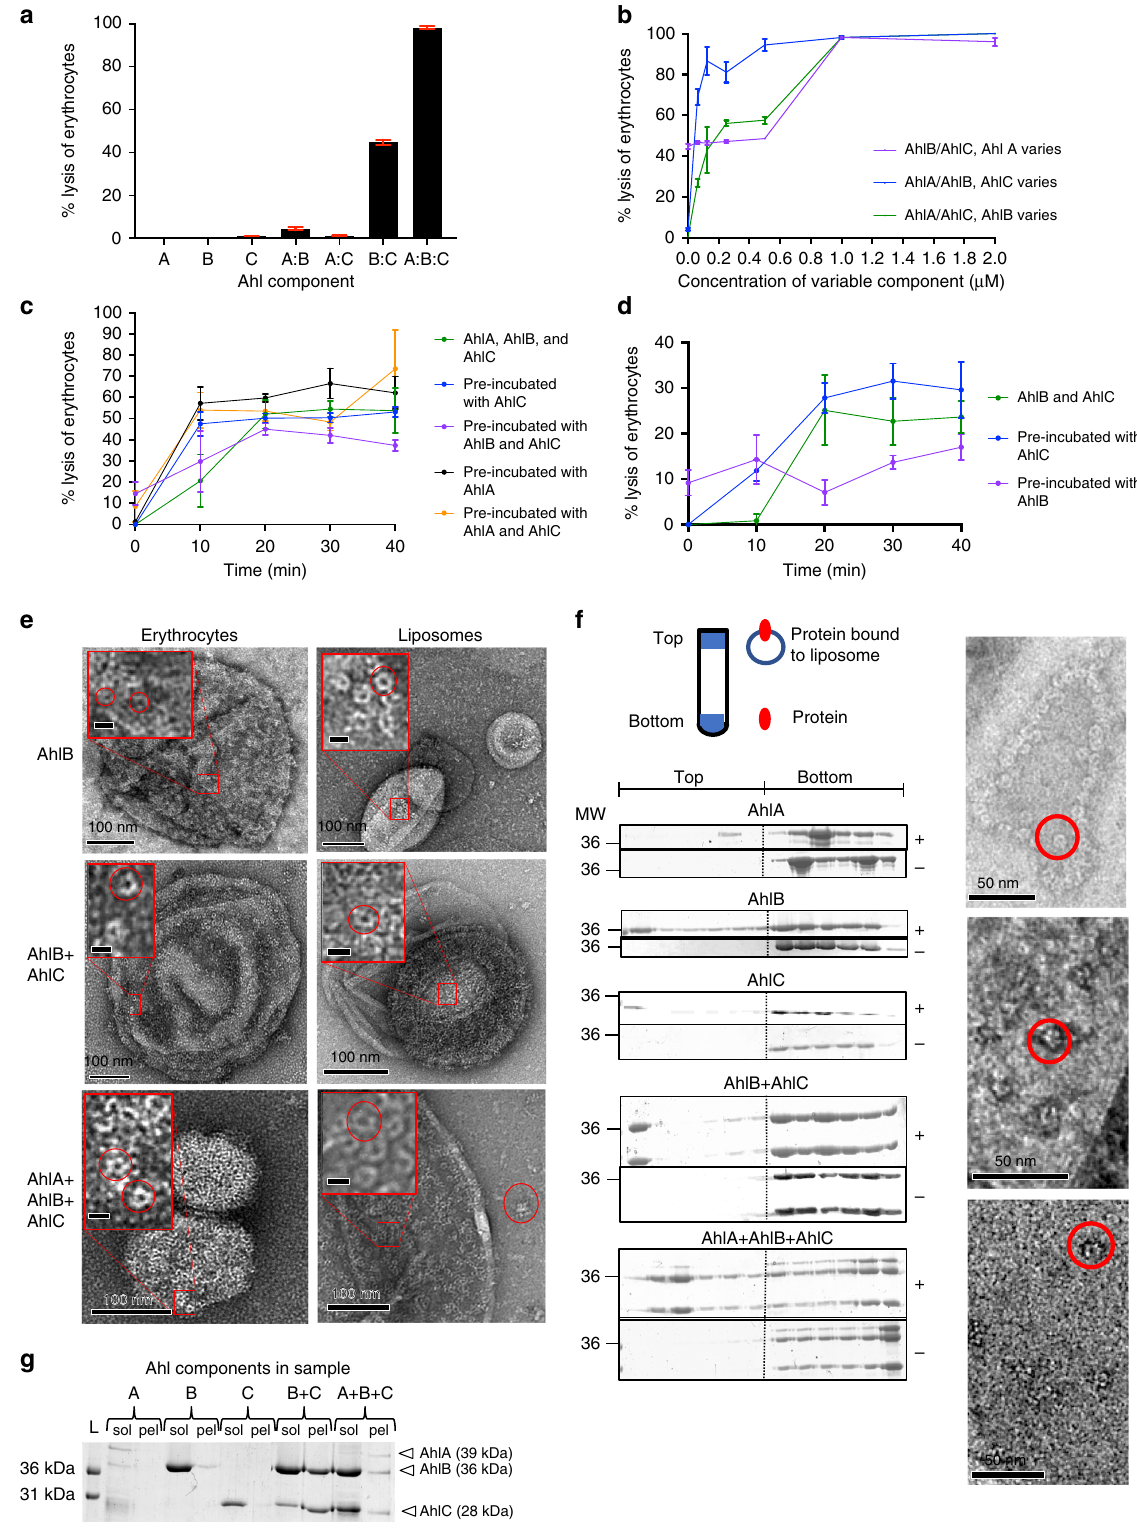
strands ( β 1 and β 2; the β -tongue) (Fig. 2b). These hydrophobic residues are thus shielded from solvent by packing against resi- dues of helix α 4 (E254 – V270), α 3a (residues V170 – L186), α 4a (residues G225 – G239), the N-terminal helix ( α 1, residue G12 – V34) and the C-terminus (residues T331 – A359), which forms a short beta strand ( β 3) and helix ( α 5a). In this